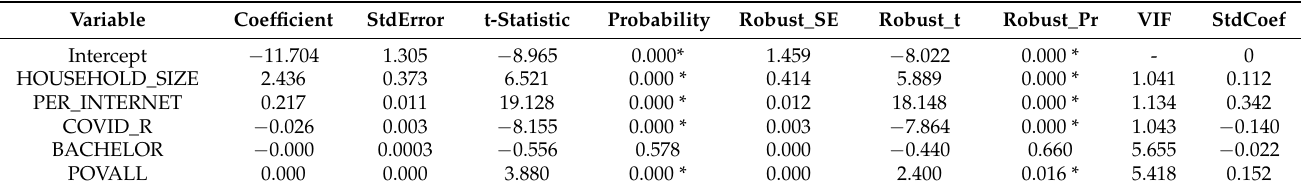
Table 5. Summary of the OLS results with five explanatory